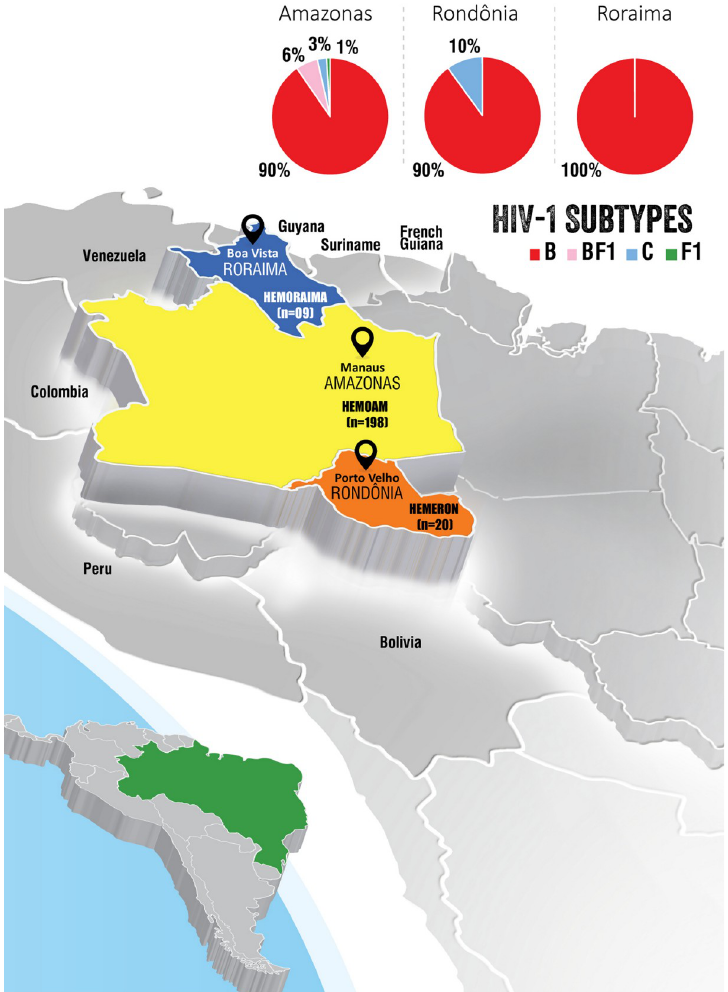
Fig 1. Map of Latin America, Brazil depicting our study area in the Northern Brazilian states of Amazonas, Rondoˆnia and Roraima. The participating blood centers are highlighted: HEMOAM in Manaus, Amazonas, HEMERON in Porto Velho, Rondoˆnia and HEMORAIMA in Boa Vista, Roraima. The proportions of the HIV-1 subtypes B, F1, C and BF1 recombinants identified in each hemocenter are shown in the